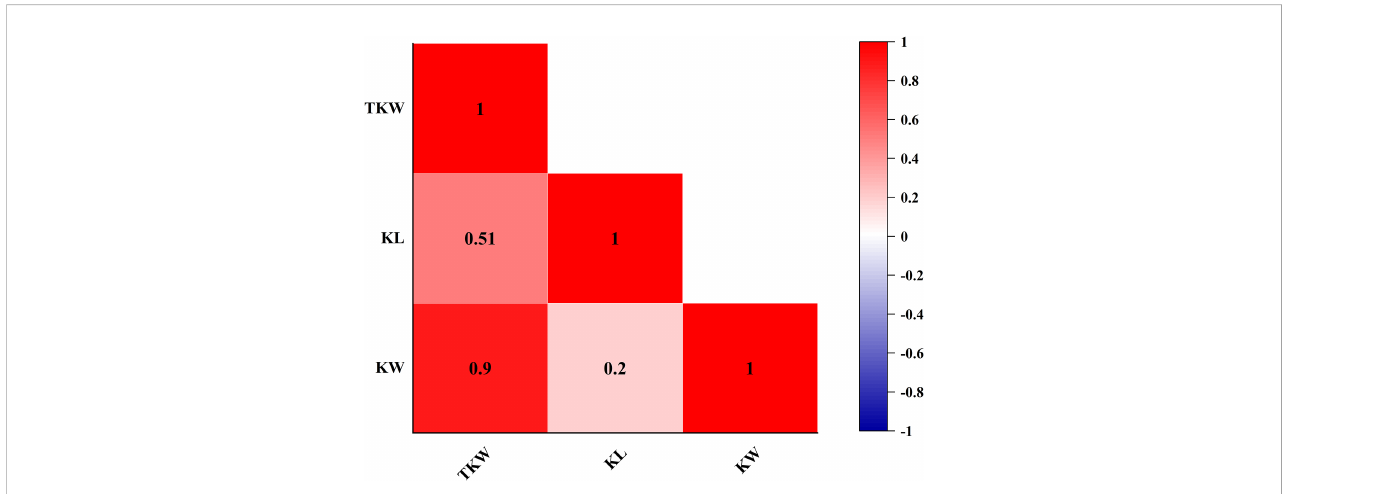
FIGURE 3 Heat map of Pearson ’ s correlation of fructan content by using BLUE